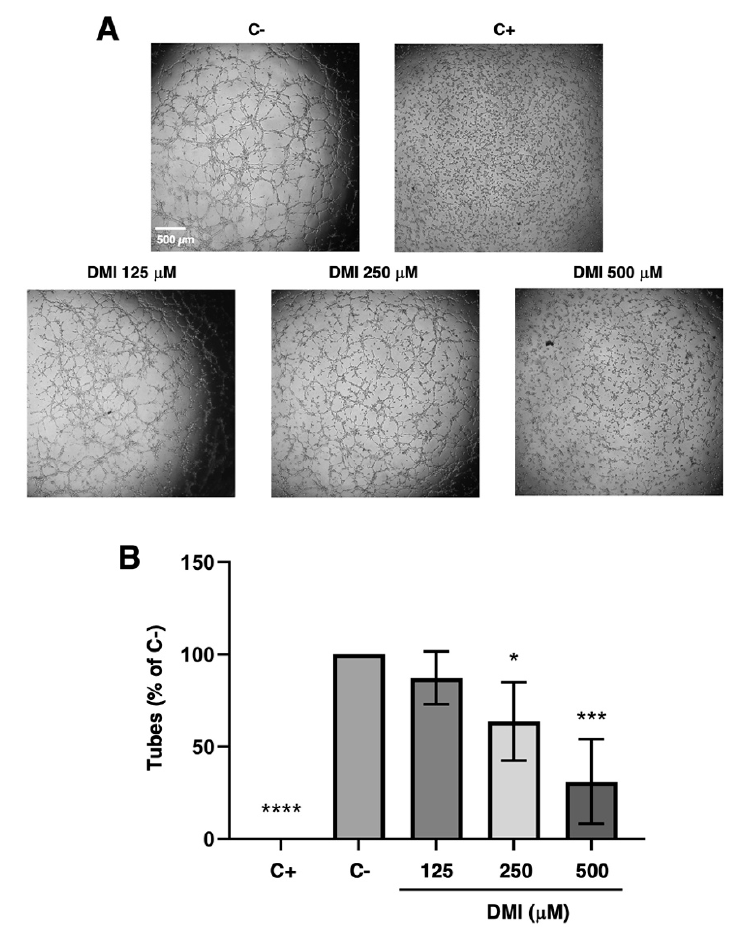
Figure 3. Effect of DMI on the formation of endothelial tubular structures. ( A ) Representative images of negative (DMSO, at non-toxic concentrations, well below 1% v / v ) and positive control (2 µ M staurosporine) [9] and DMI-treated BAECs on tube formation of Matrigel. Control cells formed tube-like structures. Cells were photographed 5 h after seeding and drug administration under an inverted microscope. ( B ) Quantitative analysis of “tubular” structures formed. Data are represented as means ± S.D. for four independent experiments. * p < 0.05, *** p < 0.001, **** p < 0.0001 versus negative control.